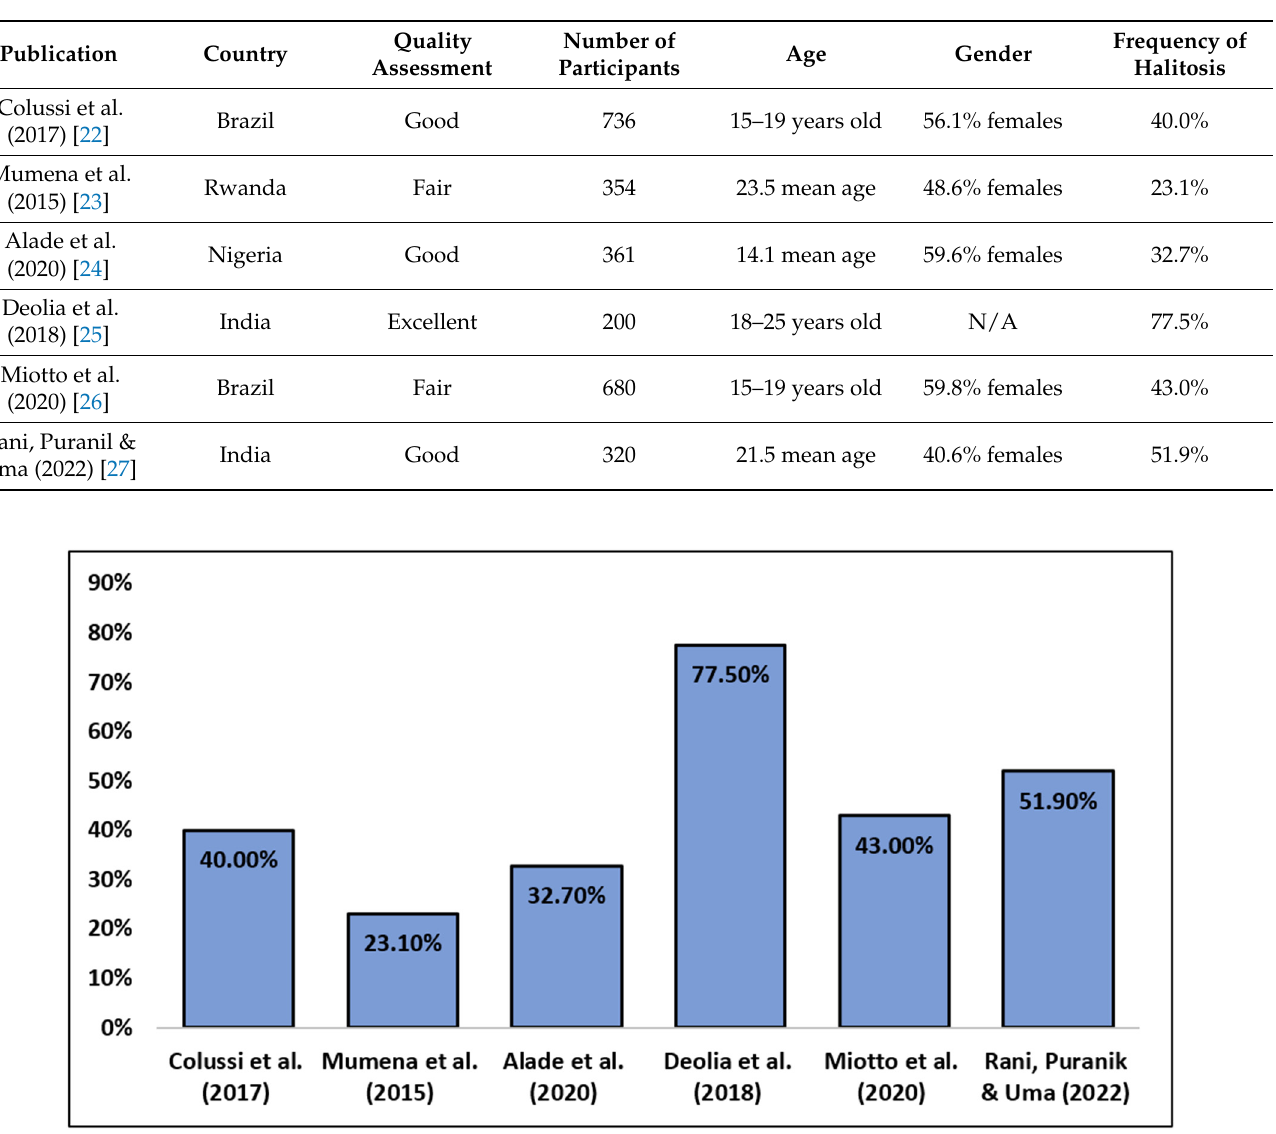
Table 1. Demographic characteristics of studies.